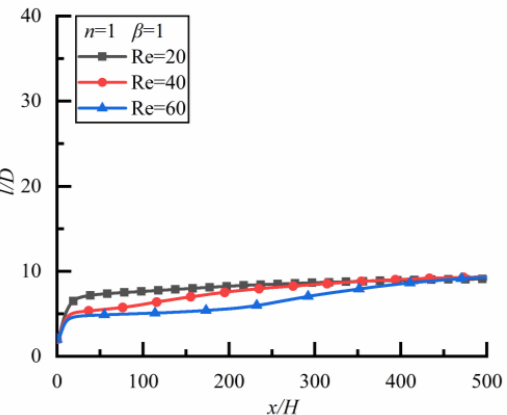
Figure 7. Changes of l/D along flow direction for different Re in a Newtonian fluid.